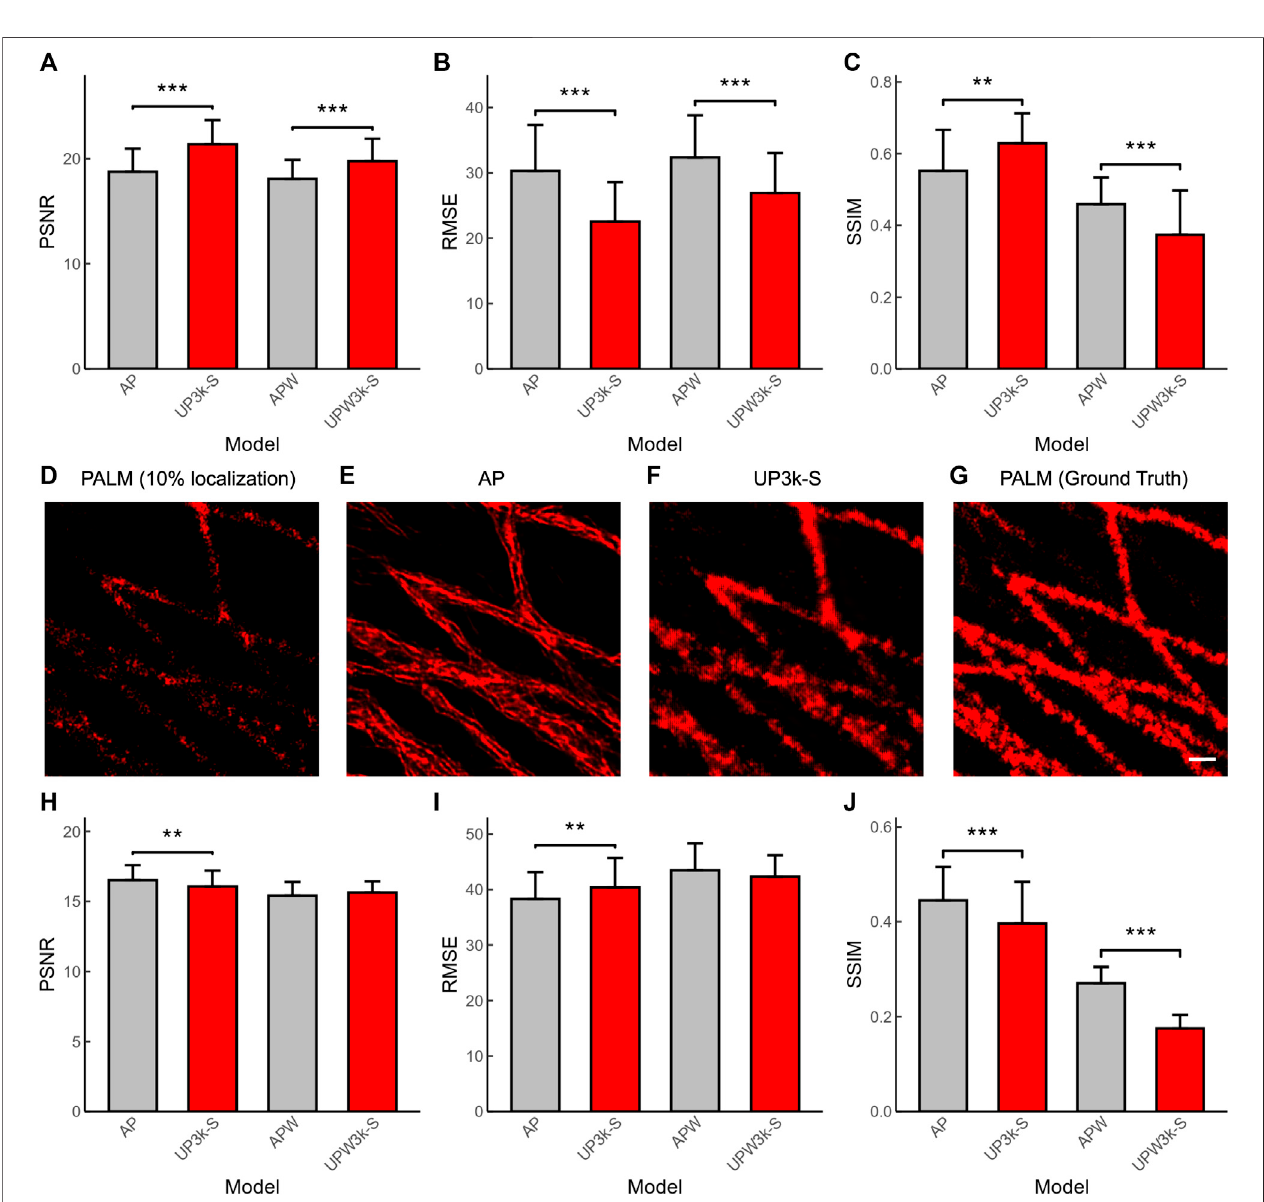
FIGURE 5 | Quanti fi cation of the performance of U-PAINT models and ANNA-PALM (AP). The performance of U-PAINT models and AP in DNA-PAINT reconstructionasanalyzedbyPSNR (A) ,RMSE (B) ,andSSIM (C) . (D) Arepresentativeimageofsparse-localizedPALMasreconstructedbythetraditionalmethod.The accelerated reconstruction images by ANNA-PALM (E) and U-PAINT (F) and the ground-truth image (G) . The performance of U-PAINT models and AP in PALM reconstruction as analyzed by PSNR (H) , RMSE (I), and SSIM (J) . Red bars refer to U-PAINT models; bars are average values; error bars show s.d.; ** represents p < 0.01and***represents p < 0.001,astested bytwoindependentsample t -test. AP:ANNA-PALMpre-trainedmodelwithasparse localizationimageasinput;UP3k- S: U-PAINT (3,000) model trained with real and simulated data; APW: ANNA-PALM pre-trained model with a sparse localization image and a wide fi eld image as inputs; UPW3k-S: U-PAINT (WF+3,000) model trained with real and simulated data. Scale bar: 200 nm.